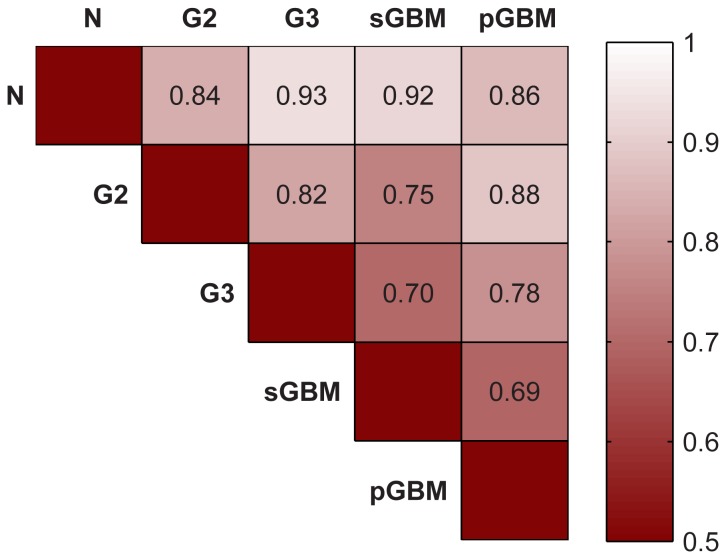
Classification accuracy with BioCarta database networks.This heatmap displays leave-one-out cross-validation accuracies of DIRAC-based classifications on each phenotype vs. all other phenotypes. DIRAC could distinguish more distant grades like normal vs. GBMs; it is especially hard to separate G3 or pGBM from sGBM.